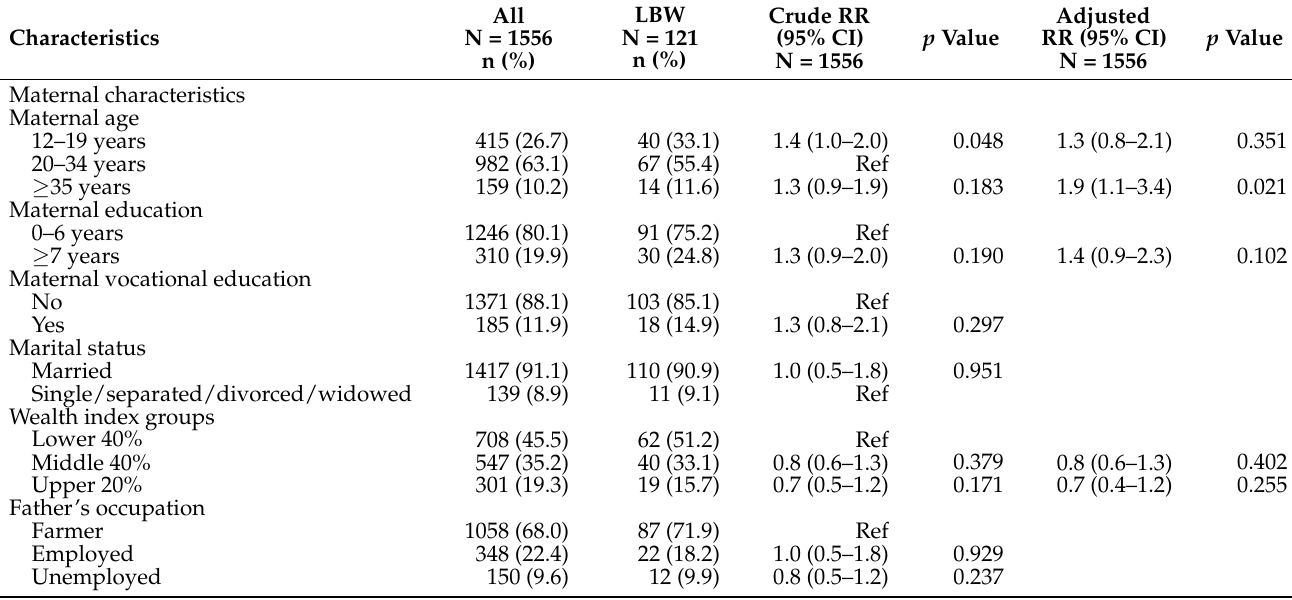
Table 3. Bi- and multi-variable analysis of risk factors for low birthweight in northern